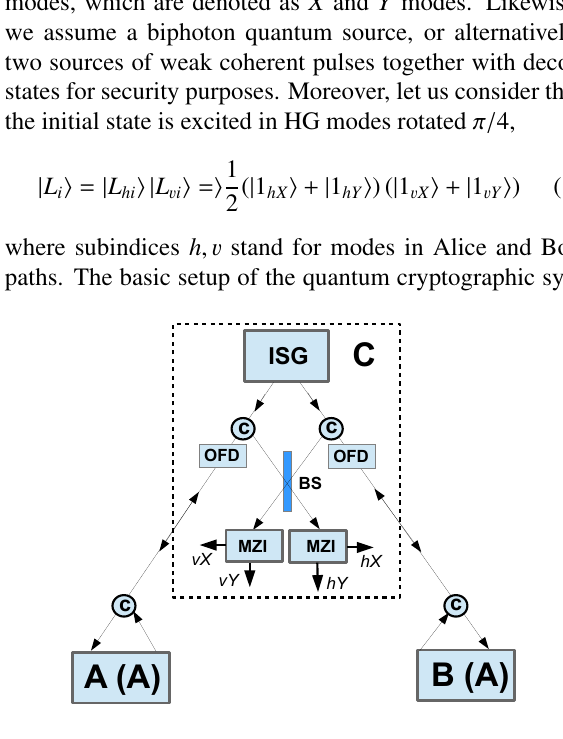
Figure 1. Basic setup of the cryptographic A-MDI-QKD